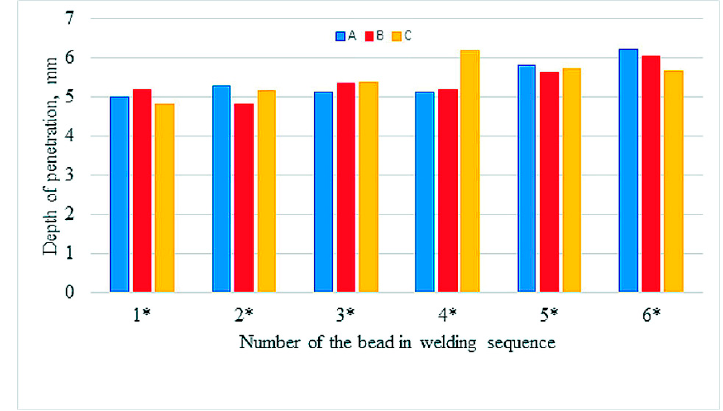
Figure 6. Height of the reinforcement in welding sequences. Materials 2020 , 13 , x FOR PEER REVIEW